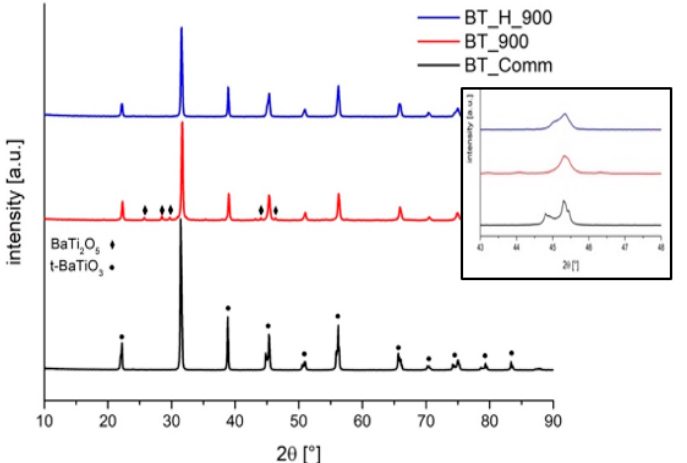
Figure 7. XRD patterns of BT_comm, BT_900, and BT_H_900. The signal at 2 θ = 45° is shown in the figure inset.